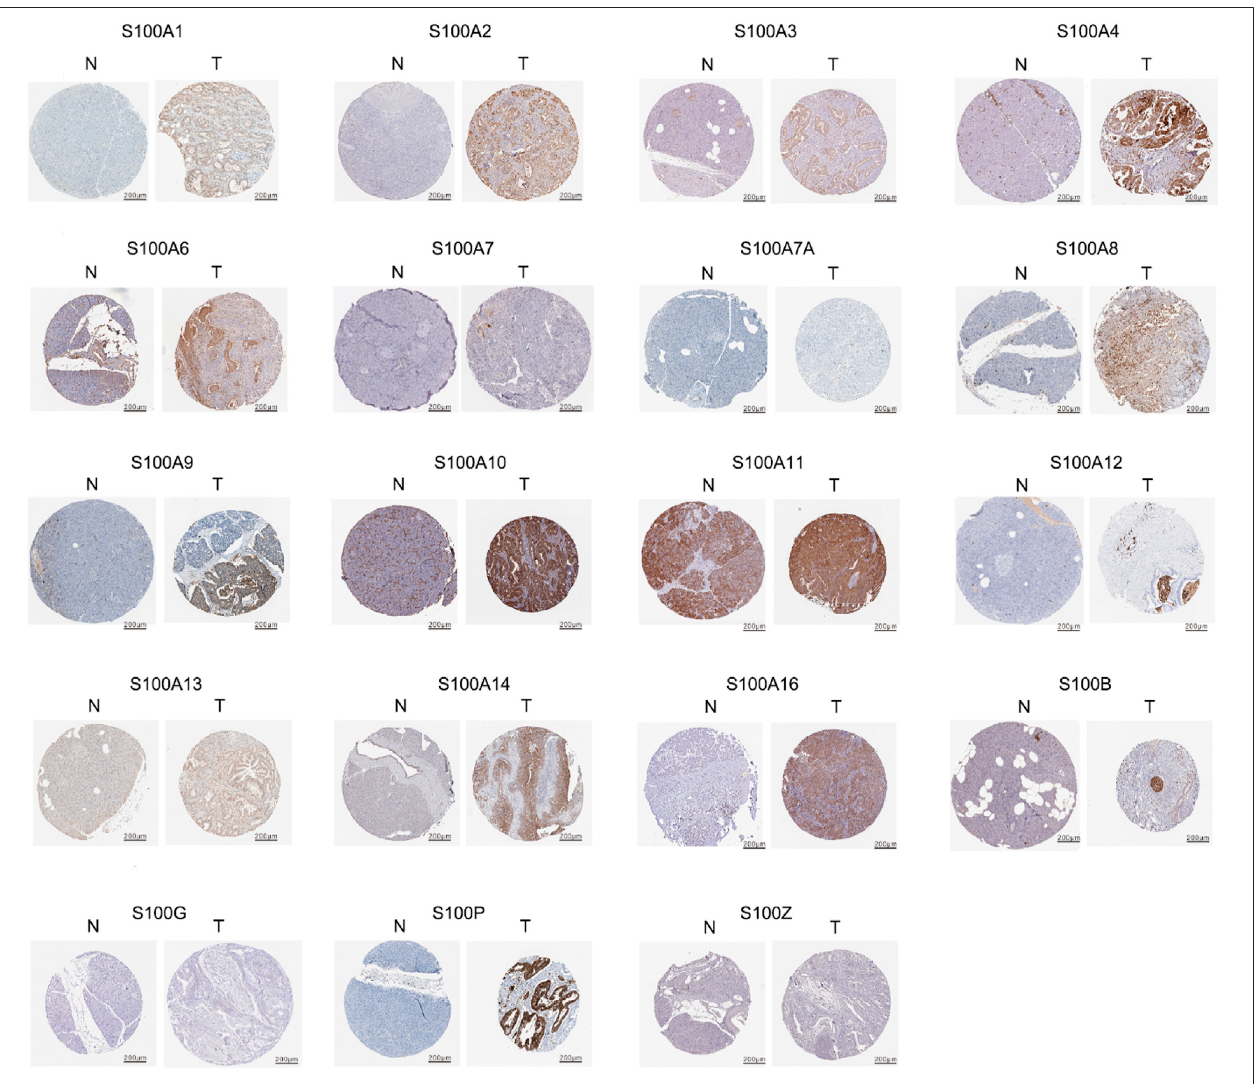
FIGURE 3 | Representative immunohistochemistry images (IHC) of the S100 family members in PAAD and normal pancreatic tissues using HPA database. The expression of S100A5 protein was not shown in the database. The expression of S00A7/A7A/A8/A9/A12/A14/A16/B/P/G/Z proteins were not detected in normal pancreatic tissues. The remain of S100 protein was expressed at low to moderate levels in some normal pancreatic tissues. Low protein expression of S100A2/A3/A7/ A7A/A8/A13 were detected in PAAD tissues. Medium protein expression of S100A1/A4/A6/A9/A11/A16/B were detected in PAAD tissues. High protein expression of S100A10/A14/P were observed in PAAD